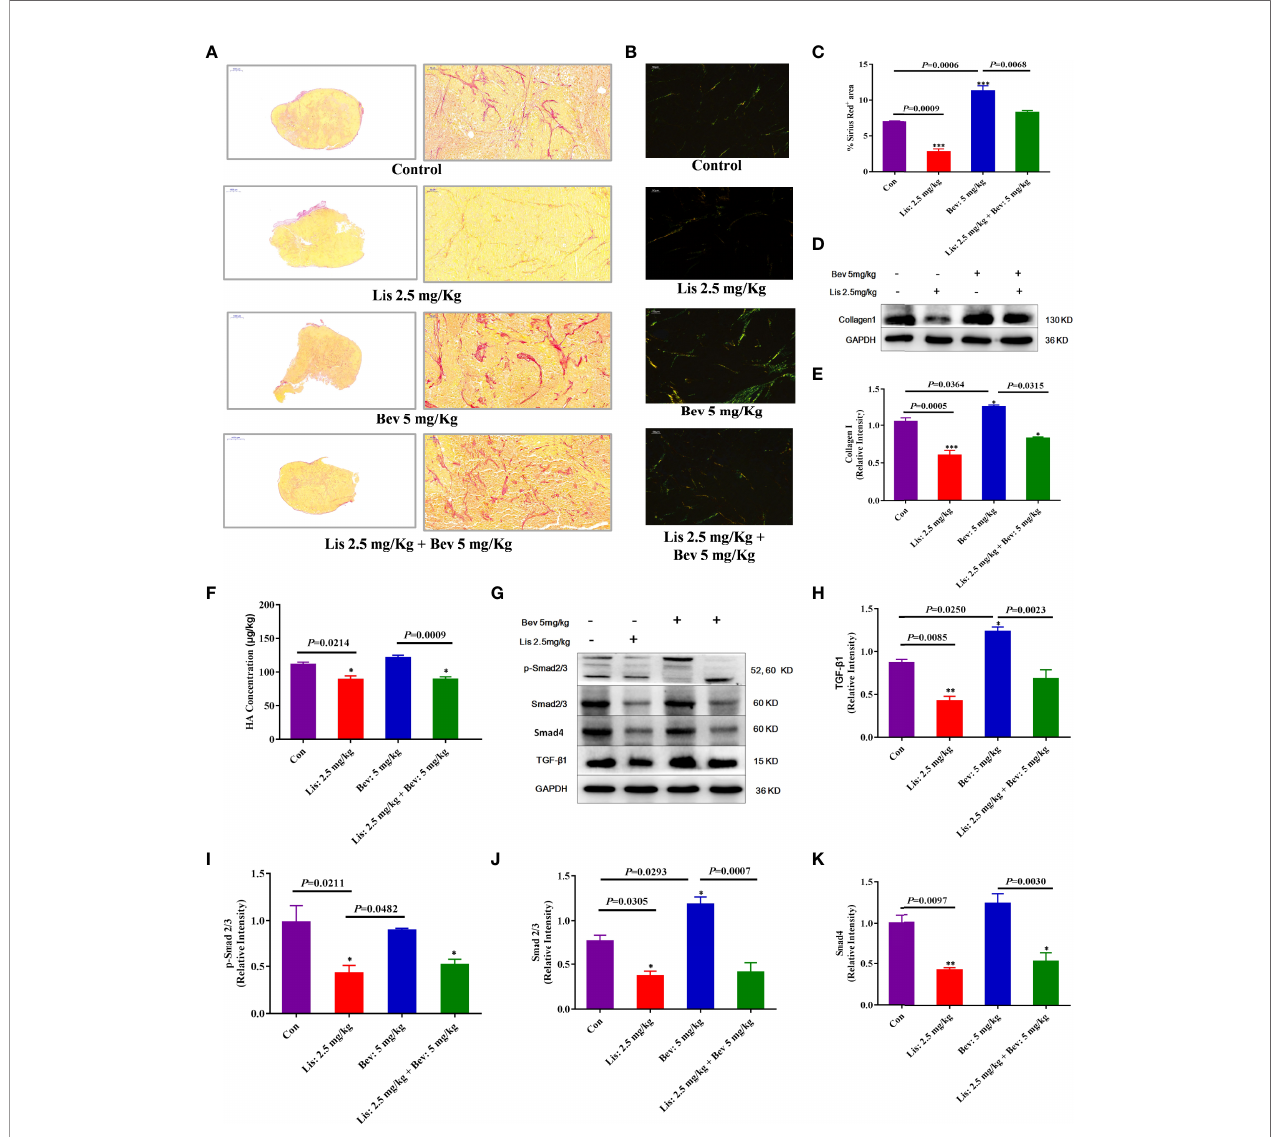
FIGURE 4 | Lis reduced ECM remodeling by Bevin HCT116 xenograft models. (A) Collagen staining by Sirius Red and imaging by light microscopy (Scale bar = 1000 m m and 50 m m). (B) Collagen staining by Sirius Red and imaging by polarized light (Scale bar = 50 m m). (C) The proportions of Sirius Red-positive areas were quanti fi ed using Image J software. For each staining experiment, with three sections per tumor (n = 3). (D) Western blot analysis of collagen I in tumor tissues. (E) Quantitative collagen I protein expression (n = 3). (F) ELISA of the HA expression level (n = 6). (G) Western blot analysis of the protein expression of ECM markers in tumor tissues. (H – K) Quantitative protein expression levels. Data are the mean ± SEM. * P < 0.05, ** P < 0.01, *** P < 0.001 versus the control group. ECM, extracellular matrix; Con, control; Bev, bevacizumab; Lis, lisinopril; HA, hyaluronic acid; TGF- b 1,transforming growth factor b